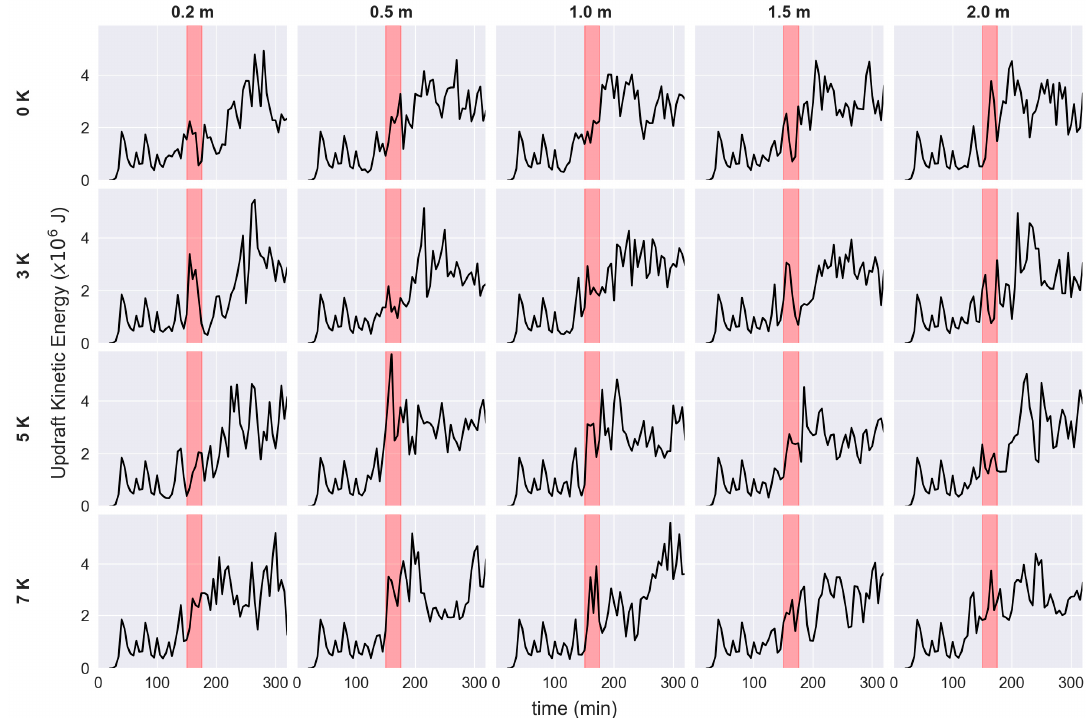
Figure 4. Time series of the updraft kinetic energy (UKE) for each simulation. The red rectangle highlights the time period when the storm is passing over the idealized